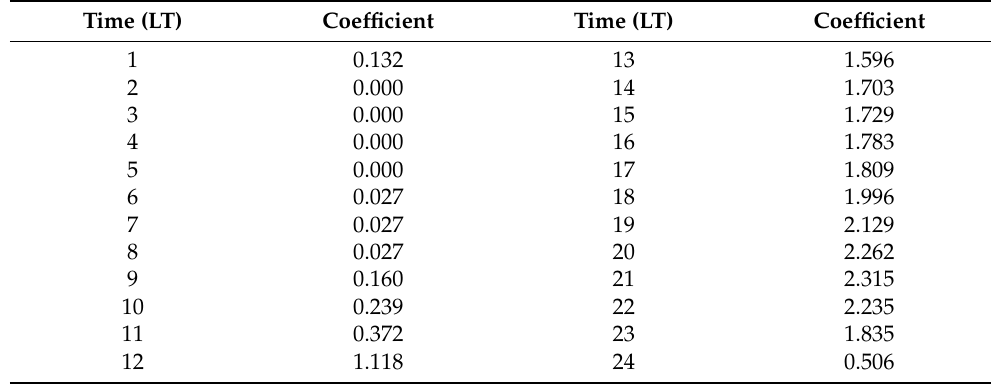
Table 8. Hourly coefficients representing the operation of commercial kitchens in Attica during weekends (in Greece, local time = UTC +2 h in winter and UTC +3 h in summer).